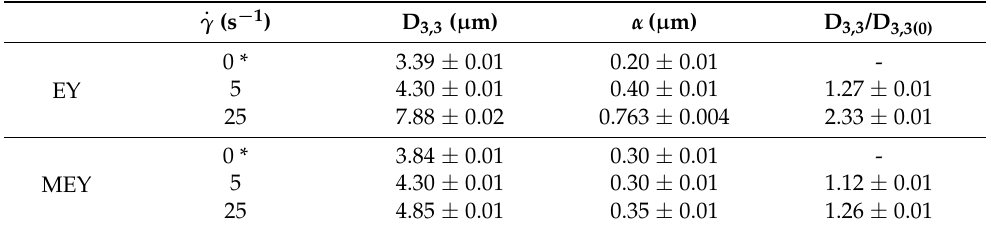
Table 2. Droplet size distribution measurements (mean diameter d 3,3 and distribution width α ) of EY and MEY emulsions before and after shearing at 5 s − 1 and 25 s − 1